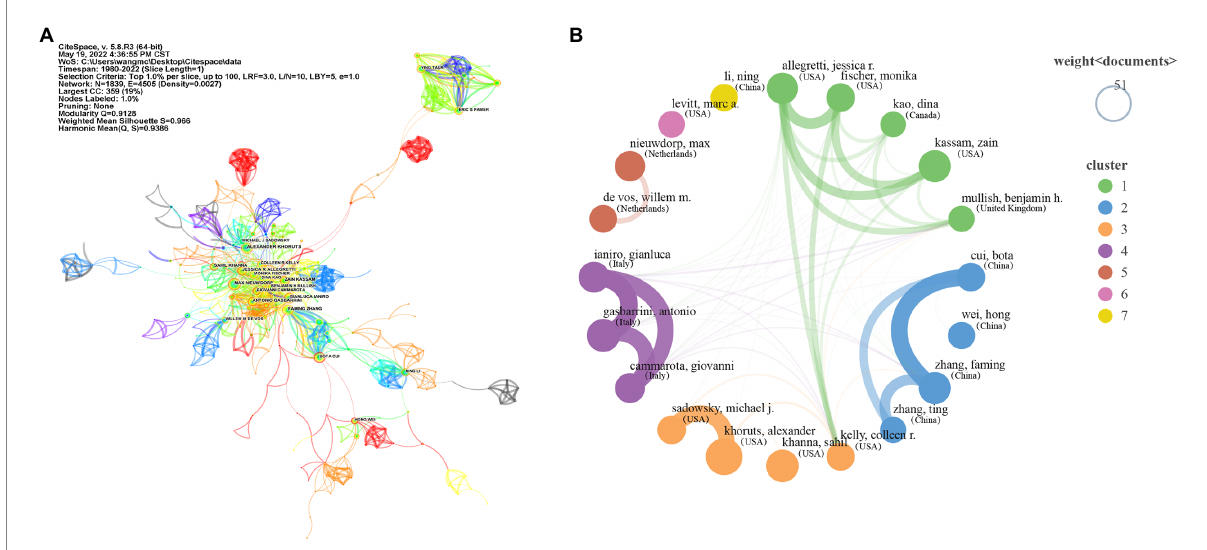
FIGURE 5 Distribution and Co-authorship analysis of authors. (A) The collaborations among the main authors and their teams on FMT. Each dot or circle represents an author, authors with the same color may be from the same research team; the line between them represents a collaborative relationship, and the width of the lines represents the strength of their cooperation. (B) The cooperative relationships of the top 20 authors with each other. The size of the circle represents the number of publications of different authors; the width of the lines between different authors represents the strength of their cooperation; authors with the same color may be from the same research